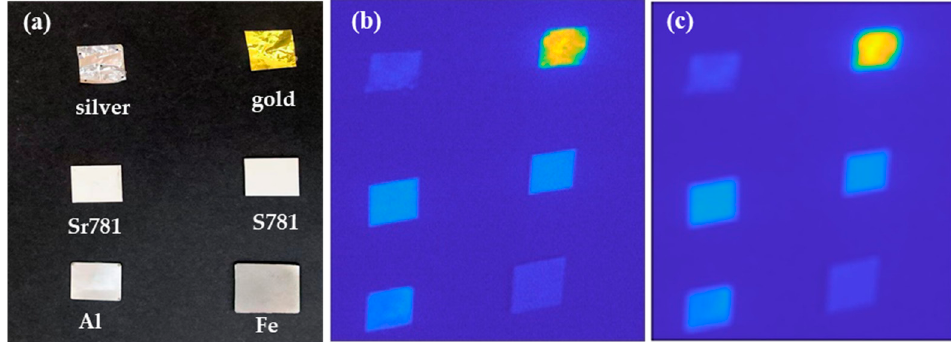
Figure 8. ( a) Physical picture, ( b ) color map, ( c ) color map after denoising.